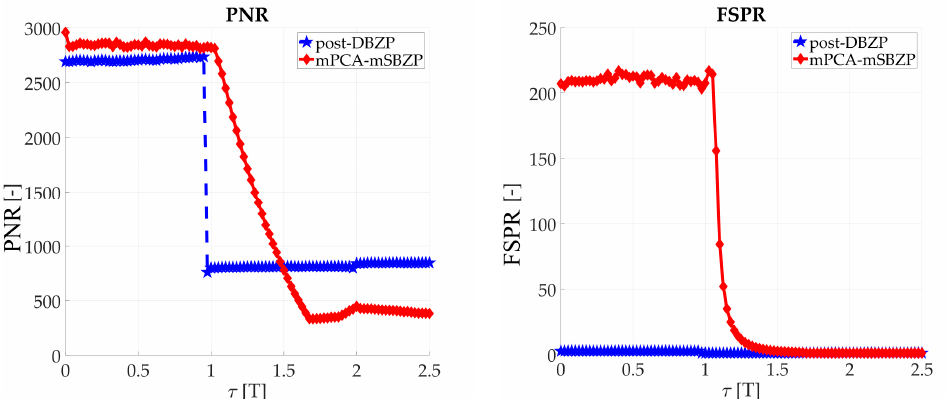
Figure 20. Results of the proposed modified processing, in first bits of SC .